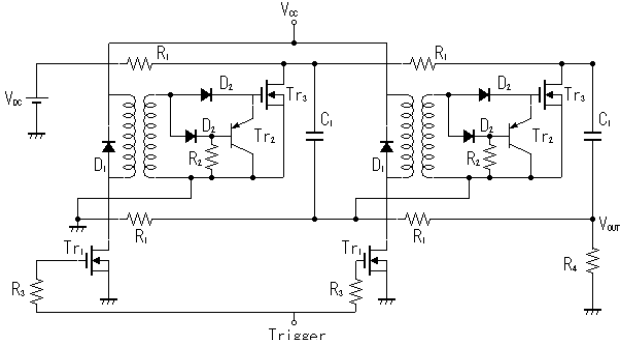
Figure 2. Marx generator circuit.